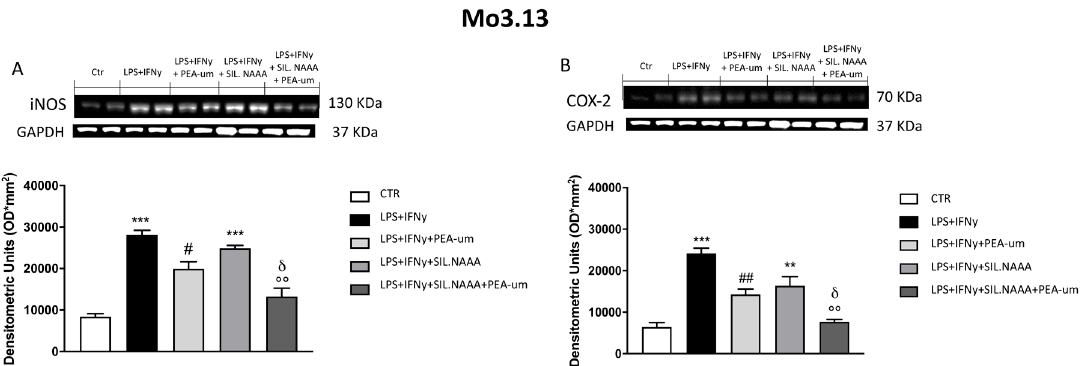
Figure 7. Effect of PEA-um treatment and NAAA-siRNA knockdown on the expression of iNOS, and COX-2 in Mo3.13 human oligodendrocytes. An increase in iNOS and COX-2 expression was observed in LPS/INF- γ group, significantly reduced by treatment with PEA-um 10 μ M ( A , B ). NAAA silencing significantly increase inflammatory markers expression, while PEA-um 10 μ M treatment counteracts the inflammatory process ( A , B ). Data are representative of at least three independent experiments. ** p < 0.01 and *** p < 0.001 versus Ctr; # p < 0.05 and ## p < 0.01 versus LPS/INF- γ ; °° p < 0.01 versus LPS/INF- γ + silenced NAAA; δ p < 0.05 versus LPS/INF- γ + NAAA silencing + PEA-um treatment.